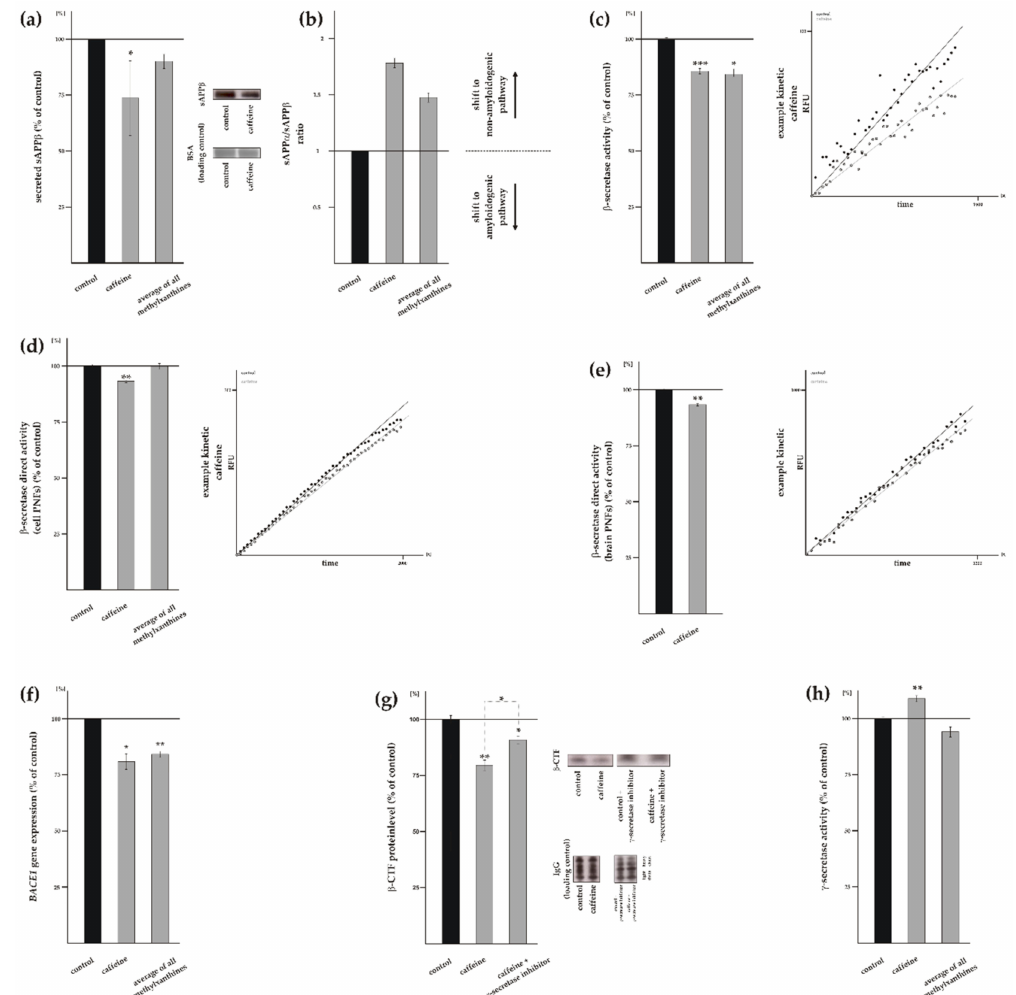
Figure 4. E ff ect of ca ff eine and other MTXs on amyloidogenic processing of APP. ( a ) Protein level of sAPP β in ca ff eine treated cells compared to solvent control ( n ≥ 13). Representative WBs including load control are shown on the right. ( b ) sAPP α / sAPP β ratio. ( c ) Activity of the β -secretase on living cells ( n ≥ 19). A representative kinetic of ca ff eine is shown on the right. ( d ) β -secretase activity in cell free post nuclear fractions of treated SH-SY5Y wt cells ( n ≥ 6). ( e ) Activity of β -secretase in ca ff eine-treated post nuclear fractions of wt mouse brain ( n = 6). Kinetics of β -secretase activity in incubated post nuclear fractions are illustrated on the right side. ( f ) Expression of BACE1 in cells treated with MTXs ( n ≥ 10). ( g ) Protein level of β -C-terminal fragment ( n ≥ 4). A significant di ff erence in the e ff ect strength between ca ff eine and the average of all MTXs was found. ( h ) Analysis of the γ -secretase on living cells after ca ff eine treatment ( n ≥ 25). Error bars represent the standard error of the mean. Asterisks show the statistical significance calculated by unpaired Student’s t test (* p ≤ 0.05; ** p ≤ 0.01; *** p ≤